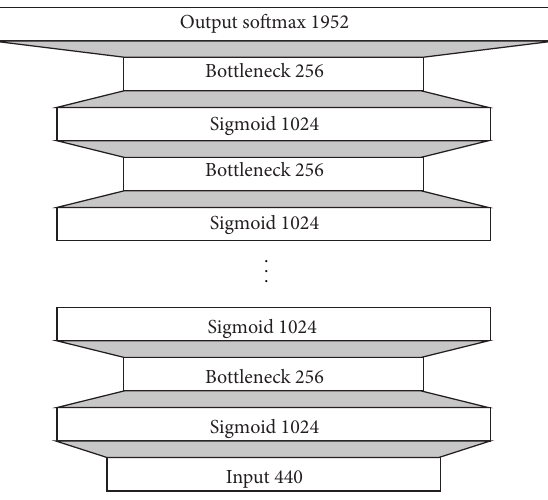
Figure 1: A model restructured by the SVD